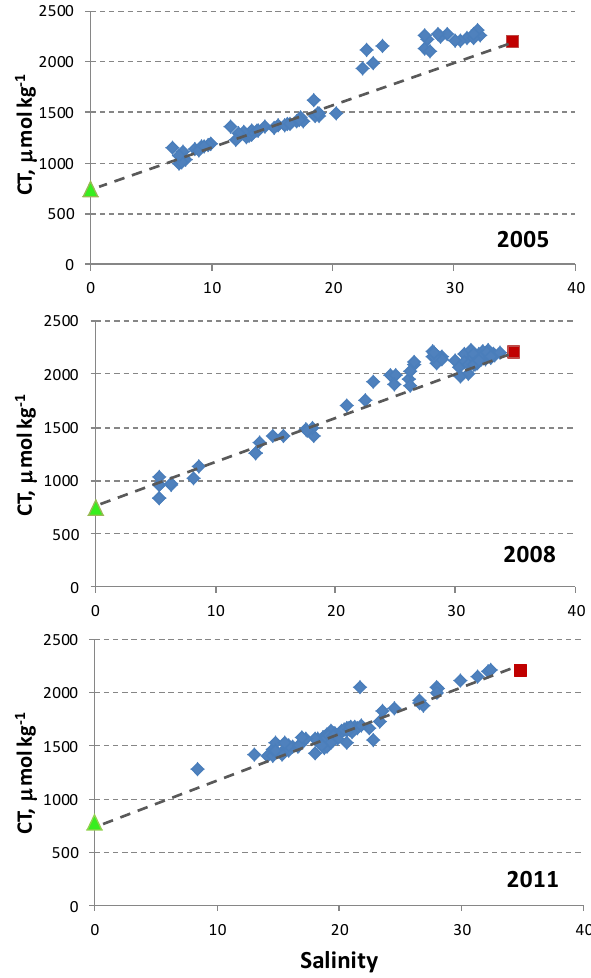
Fig. 8. Distribution of total inorganic carbon ( C T , µmolkg − 1 ) vs. salinity: green triangle represents the Lena River end member (750µmolkg − 1 vs. 0 salinity); red rectangle represents the Atlantic water end member (2164µmolkg − 1 vs. 34.9